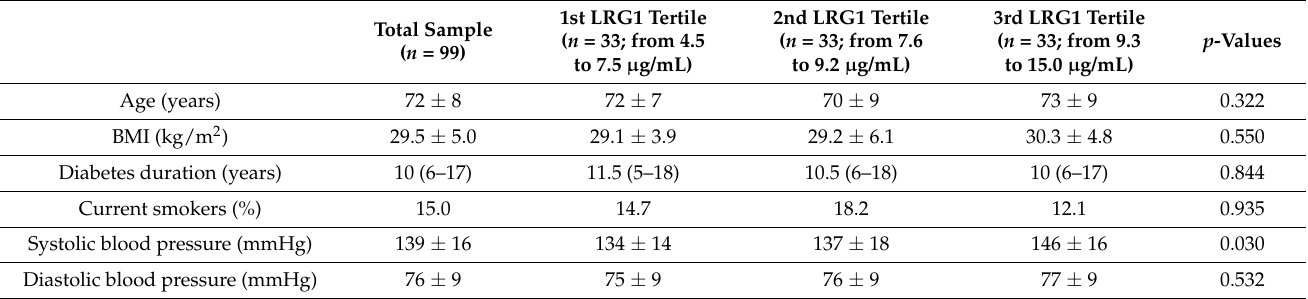
Table 1. Main clinical and biochemical characteristics of postmenopausal women with non-insulin treated T2DM, stratified by tertiles of plasma leucine-rich α -2 glycoprotein-1 levels. 1st LRG1 Tertile 2nd LRG1 Tertile Total Sample ( n = 33; from 4.5 ( n = 33; from ( n = 99) to 7.5 µ g/mL)